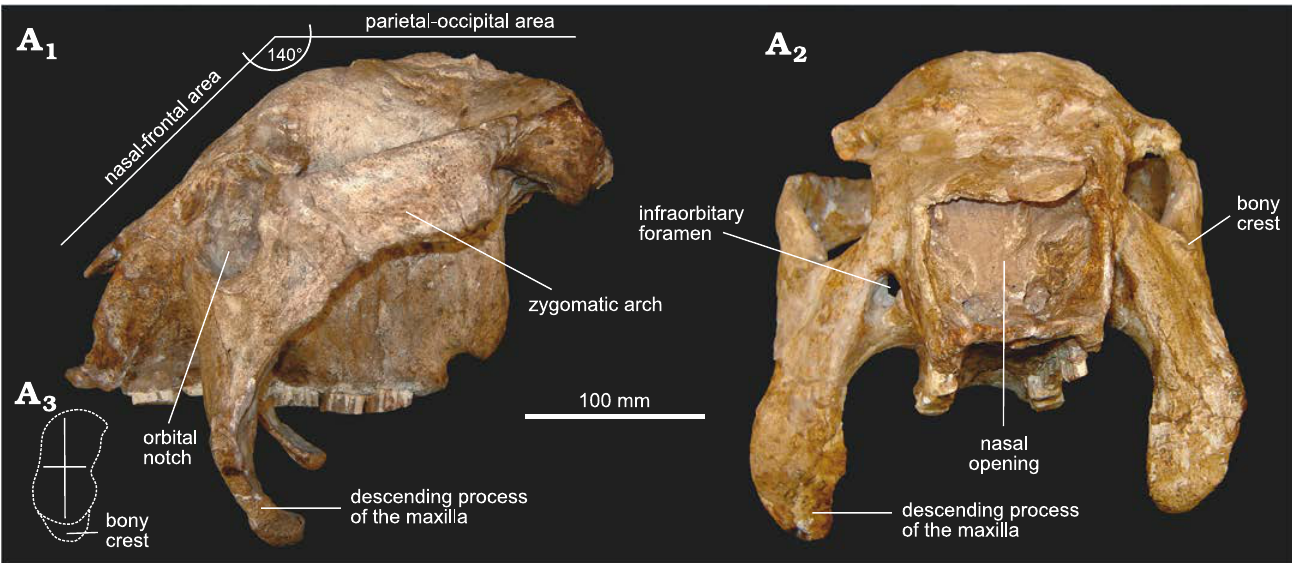
Fig. 3. Skull of doedicurine glyptodont Eleutherocercus solidus (Rovereto, 1914), FMNH-P 14437, from upper Miocene–Pliocene, Puerta de Corral Quemado, Andalhuala Formation, levels 23–28, Argentina; in left lateral (A 1 ) and frontal (A 2 ) views; drawing of detail of orbit notch (A 3 ).